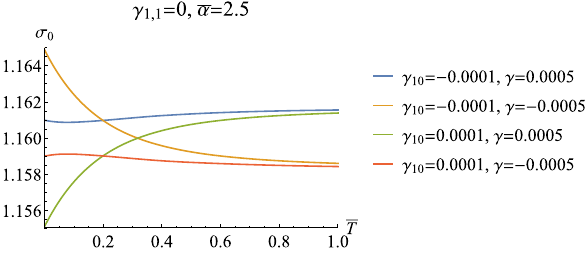
Fig. 4 Left plot: σ 0 as a function of ¯ T with γ 1 , 0 = 0 . 0005, ¯ α = 2 . 5 and for different γ . Right plot: σ 0 as a function of ¯ T with γ = 10 − 4 , 1 , 0 ¯ α = 2 . 5 and for different γ